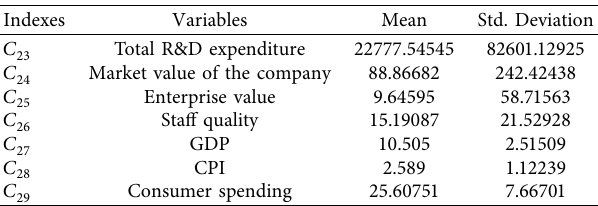
Table 4: List of independent variables for supply chain